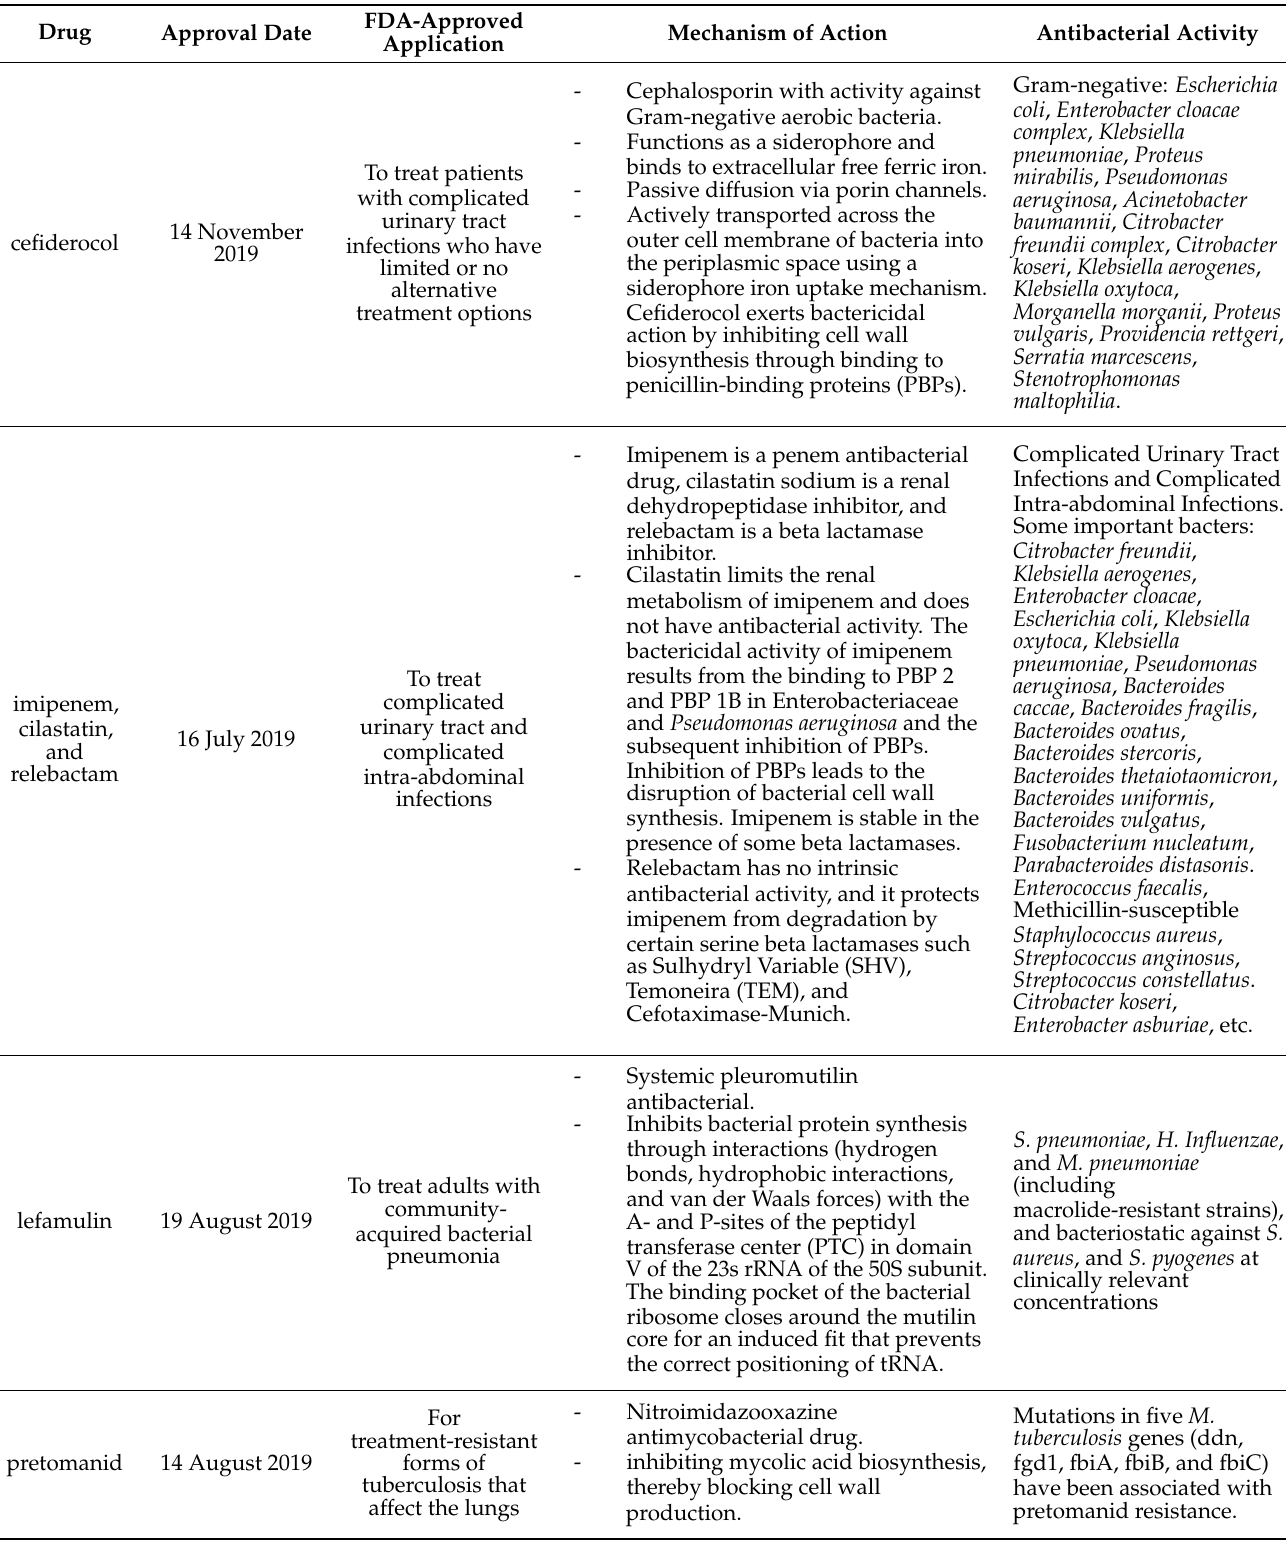
Table 1. New FDA-approved drugs; detailed review 2017–2021